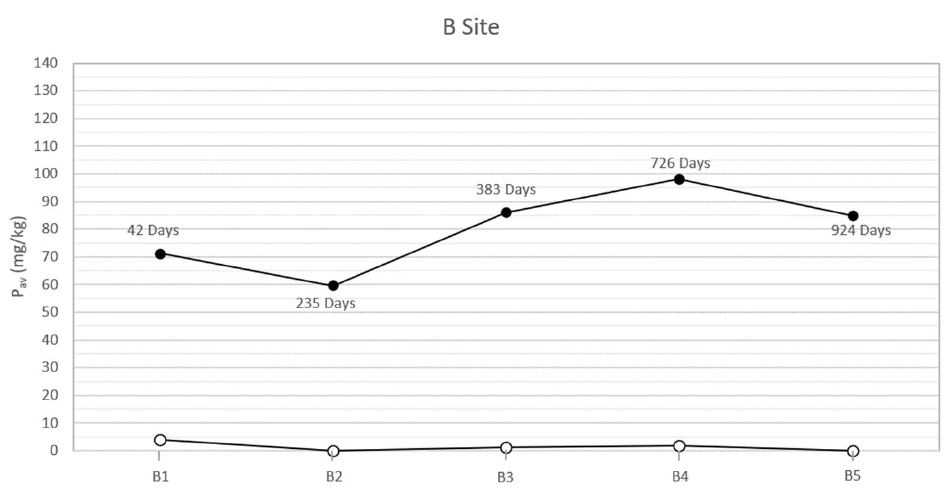
Figure 3. Soil available phosphorus of grave soil sampled for each burial (B1–B5) before the inhu ‐ mation ( ○ ) and concurrently each exhumation ( ● ) in the site B at different PBI. The soil samples have been collected below each carcass, approximately between 100 and 125 cm depth.